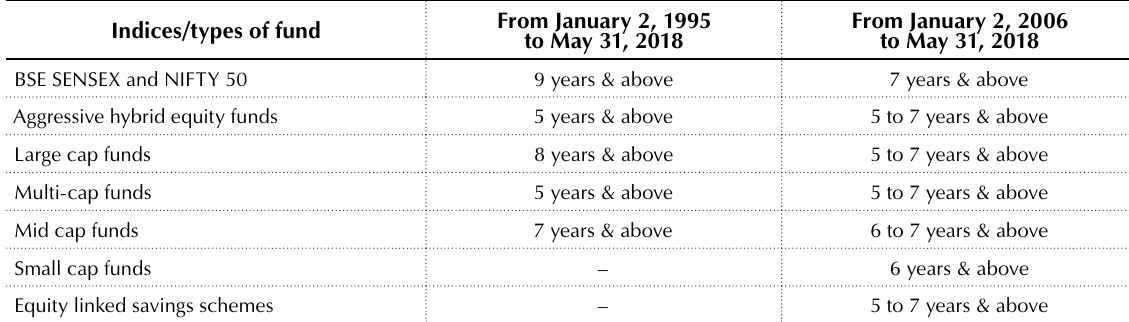
Table 23. Summary of